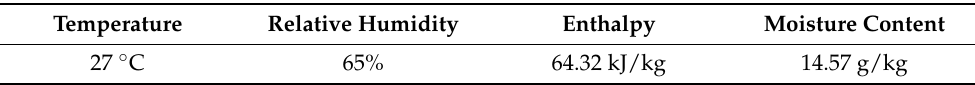
Table 2. Indoor parameters required for the calculation of the air-supply volume of air-conditioning units.